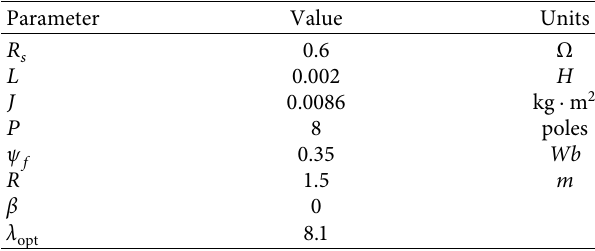
Figure 6: Control block diagram of the PMSG based on the SIS method. Table 1: Key simulation parameters of PMSG and WT.